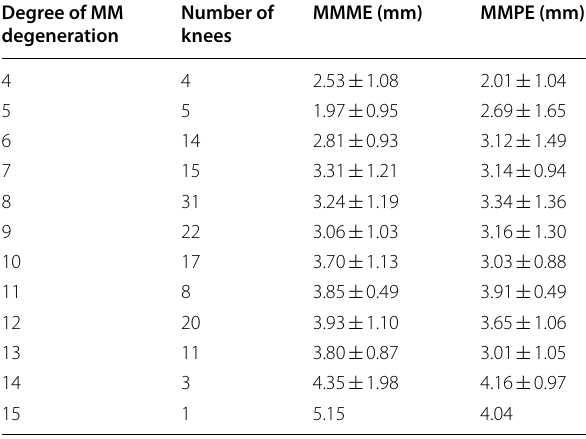
MMME medial meniscus medial extrusion MMPE medial meniscus posterior extrusion